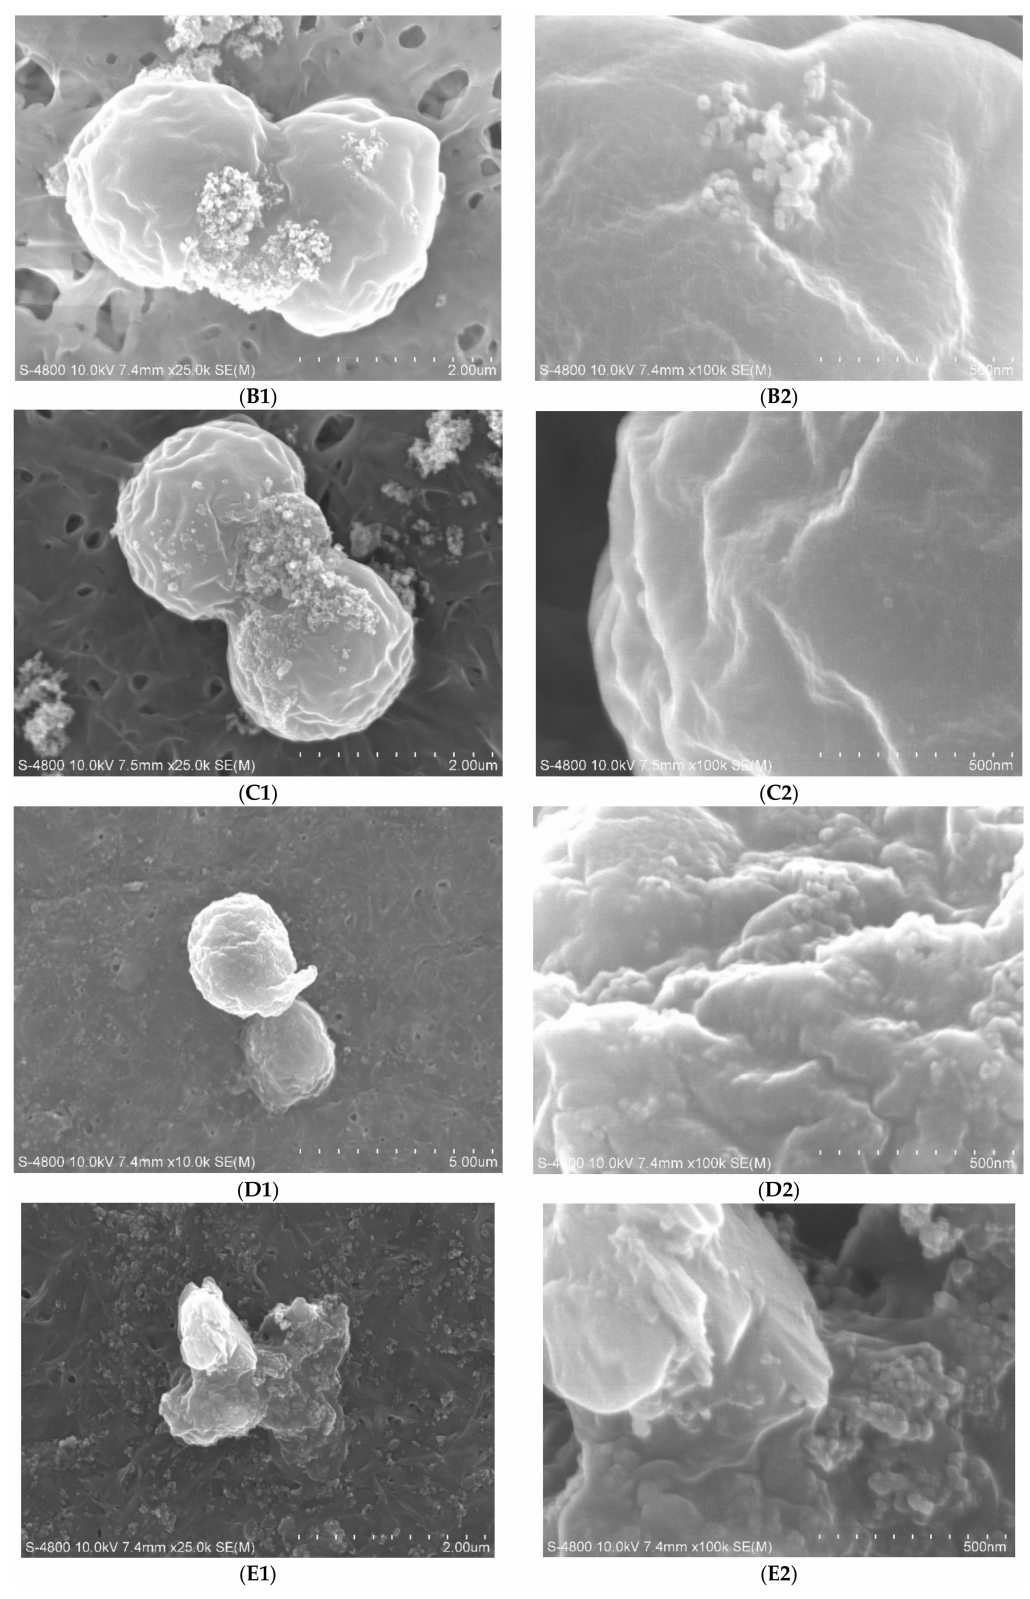
Figure 4. SEM images of M. aeruginosa cells after nano-TiO 2 mediated photocatalysis. ( A1 , A2 ): the control; ( B1 , B2 ): 1 h treatment; ( C1 , C2 ): 2 h treatment; ( D1 , D2 ): 4 h treatment; ( E1 , E2 ): 6 h